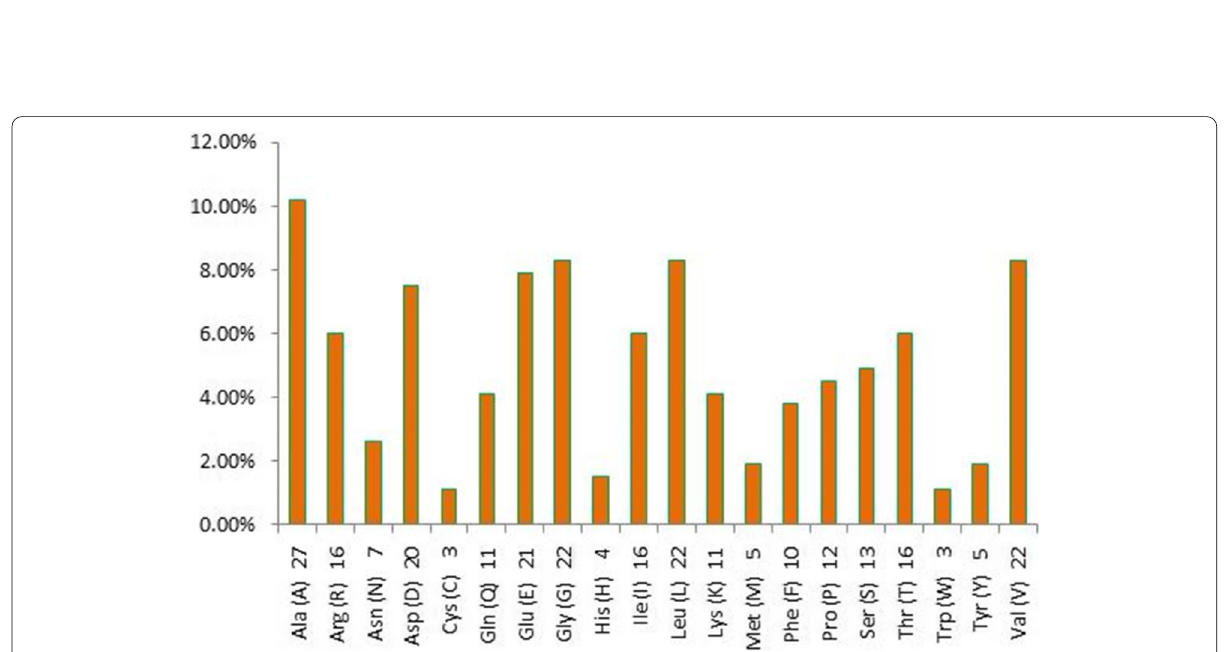
Fig. 3 Graphical representation amino acid composition of nitrilase-3